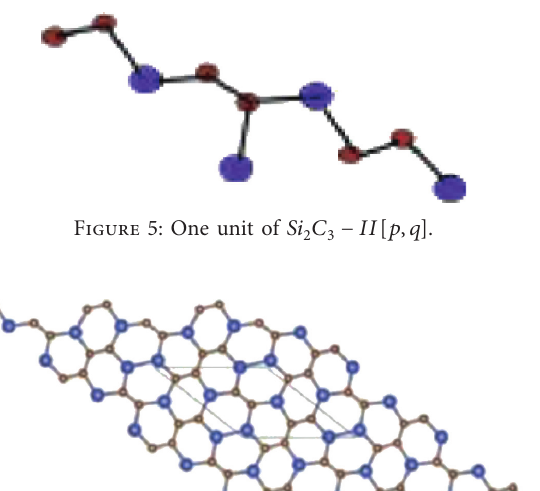
Figure 8: Sheet of Si